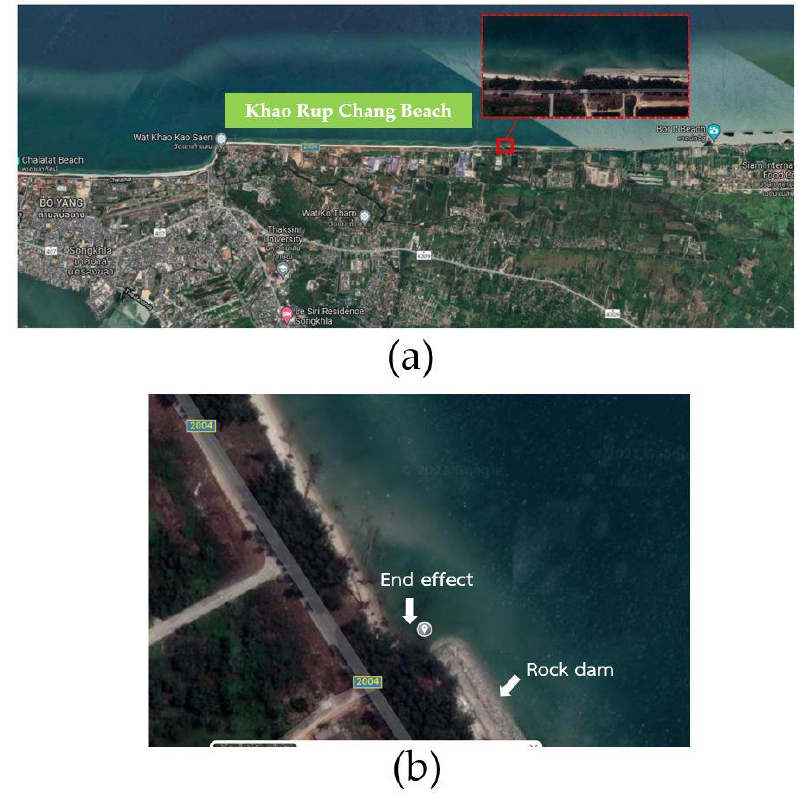
Figure 6. Khao Rup Chang Beach: ( a ) an overview and ( b ) the enlarged end effect.